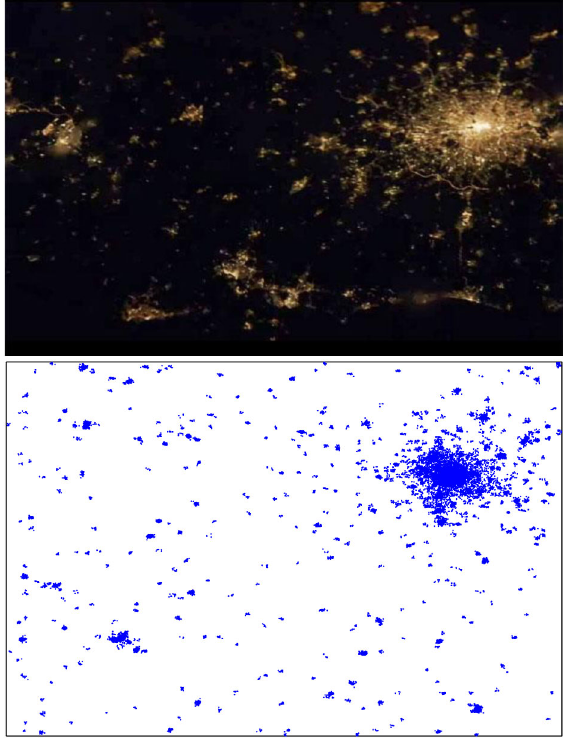
FIG. 1 (color online). Satellite picture of south England at night [23] (top panel) and computer simulation snapshot (bottom panel), selected in this case among similar results because of its particularly close resemblance to reality. The grid used for the simulation consists of M ¼ 100 divisions, corresponding to ¼ 5 , and underoccupied boxes, with n < n n th filtered